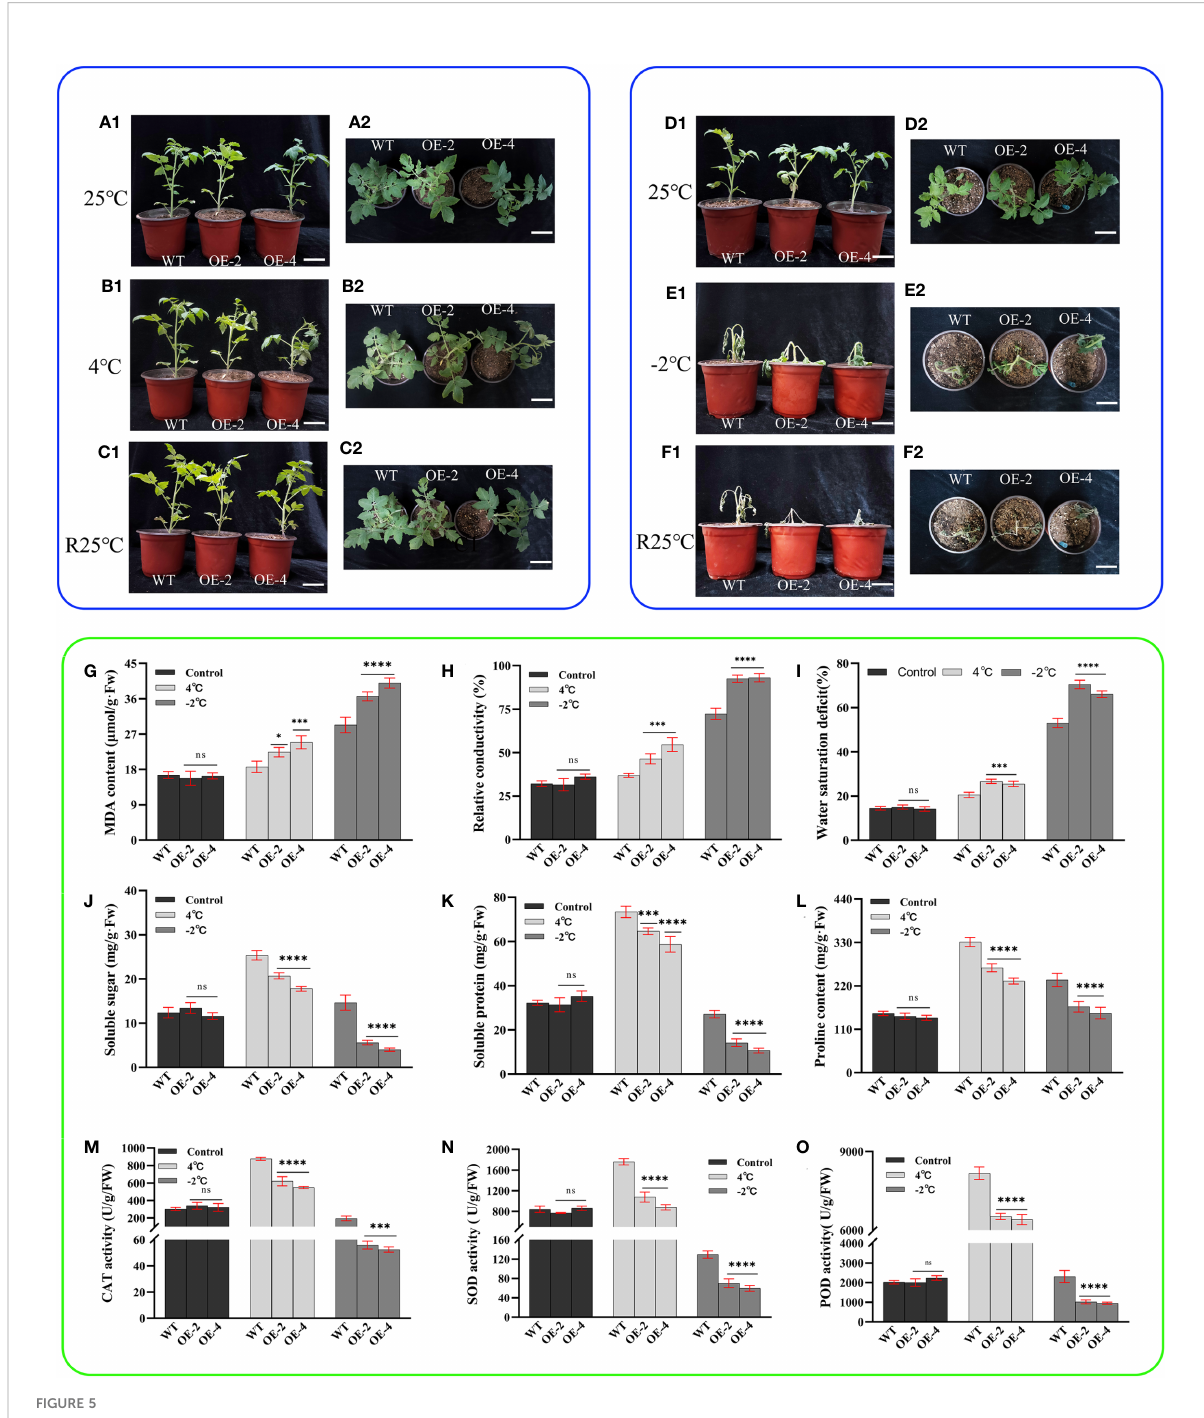
FIGURE 5 Phenotype and physiology of wild-type and transgenic tomatoes under low temperature (cold and freezing) stress. (A1) (Main view) and (A2) (Top view): Growth status of wild-type and transgenic tomatoes 4-week-old at room temperature. (B1) (Main view) and (B2) (Top view): The growth status of wild-type and transgenic tomatoes treated at 4°C for 8h. (C1) (Main view) and (C2) (Top view): The growth status of B1or B2 after 24 h of room temperature recovery. (D1) (Main view) and (D2) (Top view): Growth status of wild-type and transgenic tomatoes 4-week-old at room temperature. (E1) (Main view) and (E2) (Top view): The growth status of wild-type and transgenic tomatoes treated at -2°C for 6h. (F1) (Main view) and (F2) (Top view): The growth status of E1or E2 after 24 h of room temperature recovery. (G) MDA content. (H) Relative conductivity content. (I) Water saturation de fi cit. (J) Soluble sugar content. (K) soluble protein content. (L) Proline content. (M) CAT activity. (N) SOD activity. (O) POD activity. Data are means ± SD of three replicates. (7.2cm inner diameter, 11.5cm high.). (Ns > 0.05, *P < 0.05, ***P < 0.001, and ****P < 0.0001 for comparisons between the transgenic lines and wild-type plants by Student ’ s